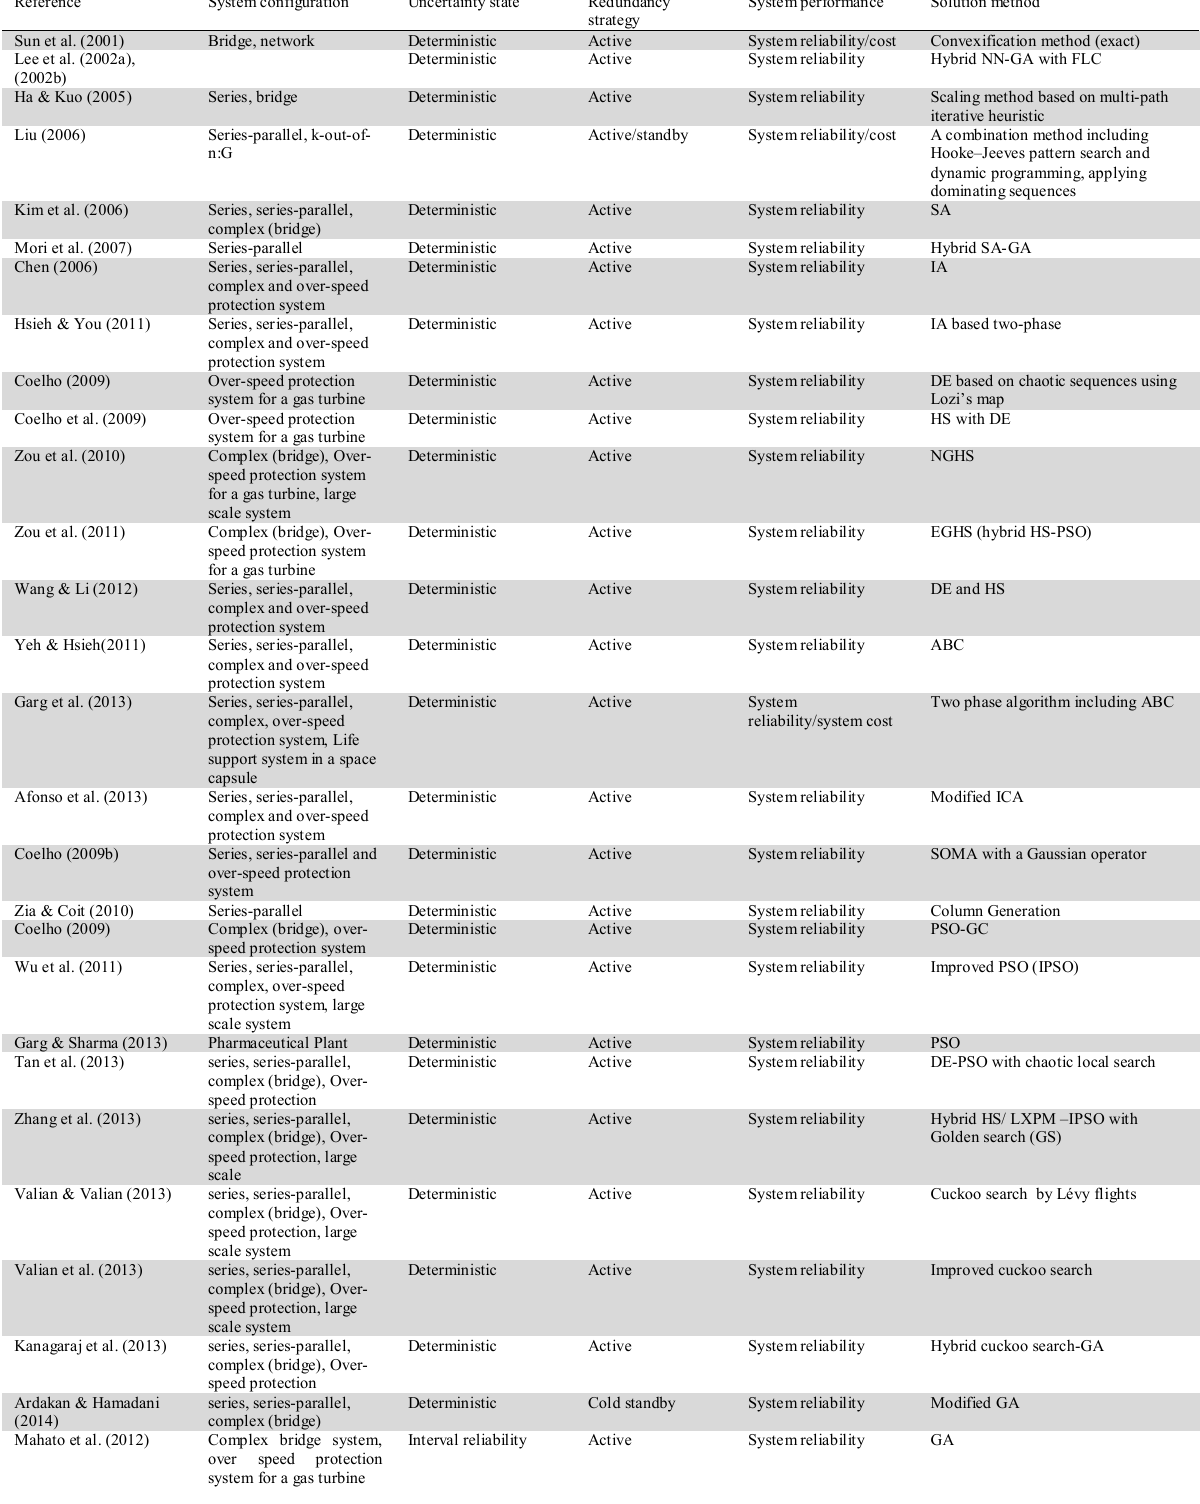
Reliability- Redundancy Allocation (Single Objective